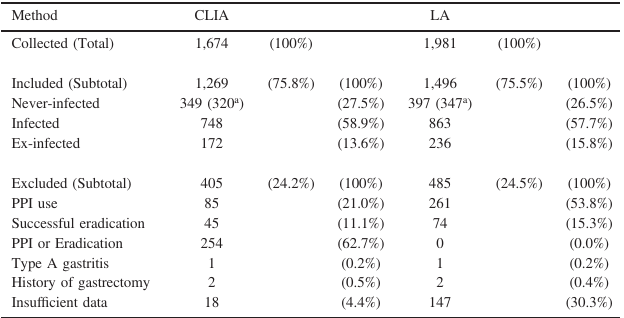
Table 1. Numbers of and details for collected, included, and excluded subjects